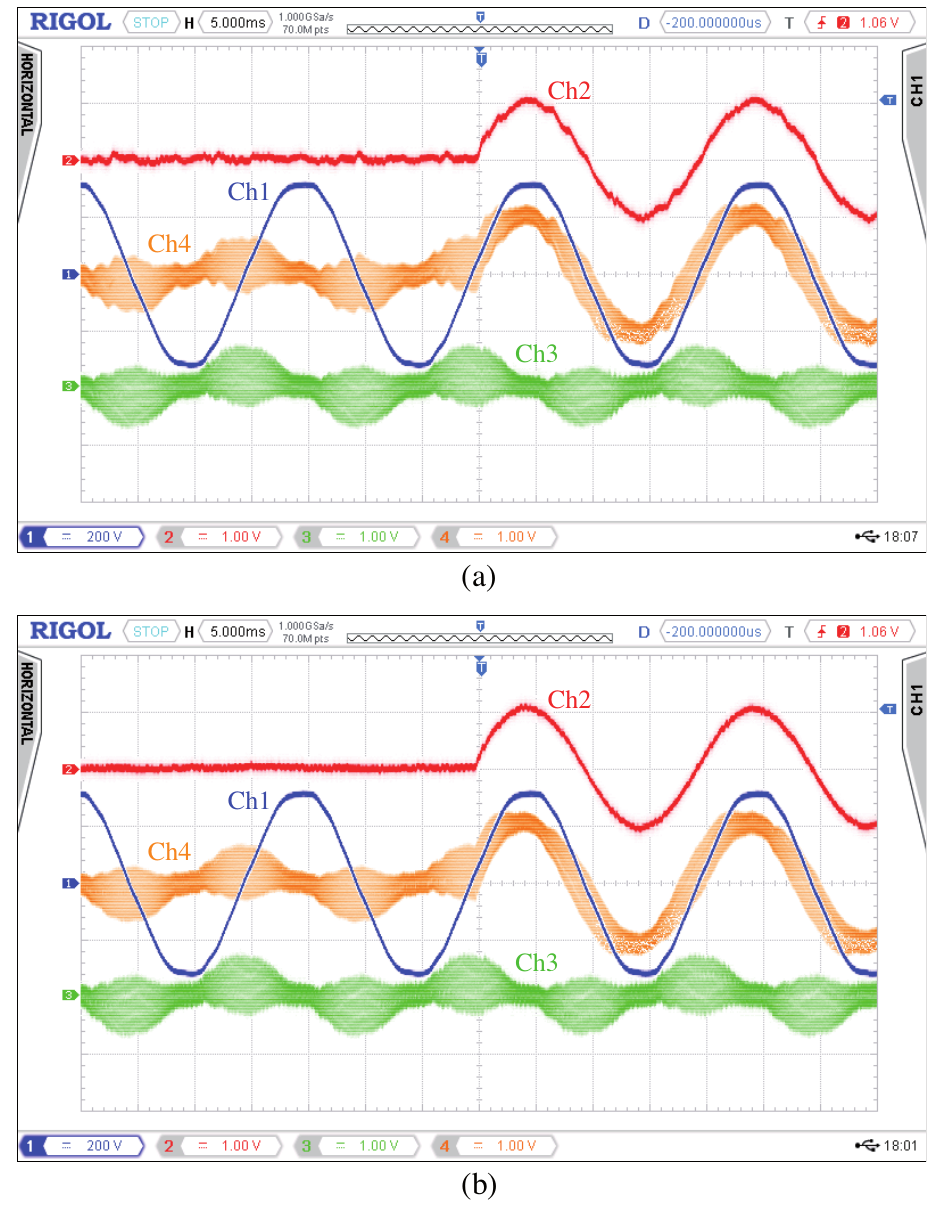
Figure 14. Comparison of the CE performance with: ( a ) PR control; and ( b ) IPCC control. Ch1: grid voltage (200 V/div); Ch2: grid current (10 A/div); Ch3: LCL capacitor current (10 A/div); Ch4: inverter current (10